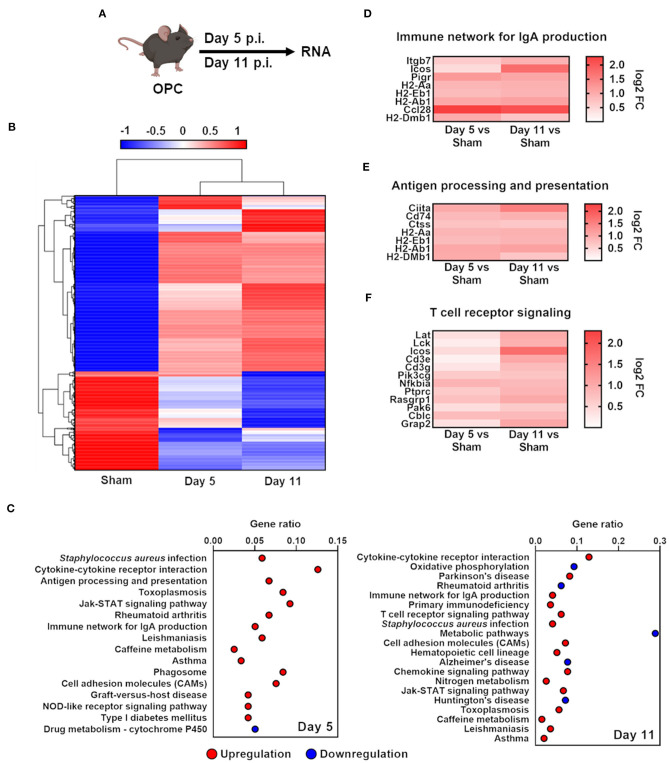
C. albicans oral colonization induces upregulation of adaptive response pathways in immunocompetent mice. (A) Scheme of infection with 529L or Sham and time points of RNA isolation. (B) Heat map showing hierarchical clustering of C. albicans colonization with 529L in the oral cavity after 5 and 11 days of genes with a fold change of FC >1.5. Red denotes genes with high expression levels, and blue denotes genes with low expression levels. The color ranging from red to blue indicates log10 (FPKM+1) value from highest to lowest. (C) Identified pathways of enriched genes FC > 1.5, adjusted P < 0.05. Shown is the gene ratio (Genes of pathway/all different expressed genes; padj ≤ 0.5). (D–F) Heat map of enriched genes of corresponding pathways.